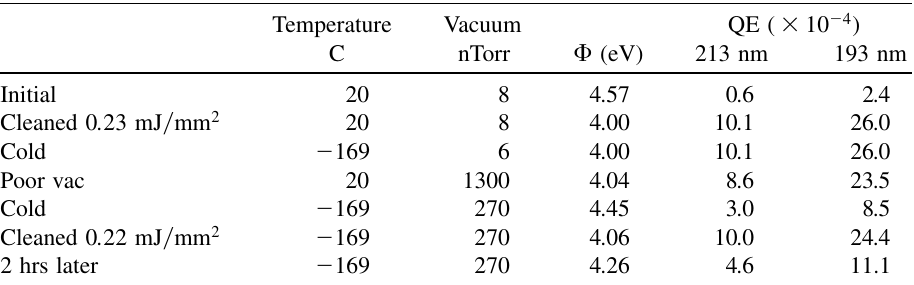
TABLE II. QE and work function for arc-deposited sample at cryogenic temperature, for both good and poor vacuum